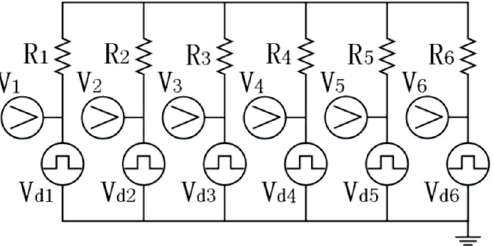
Figure 8. The control circuit of three-phase inverter-circuit power supply.